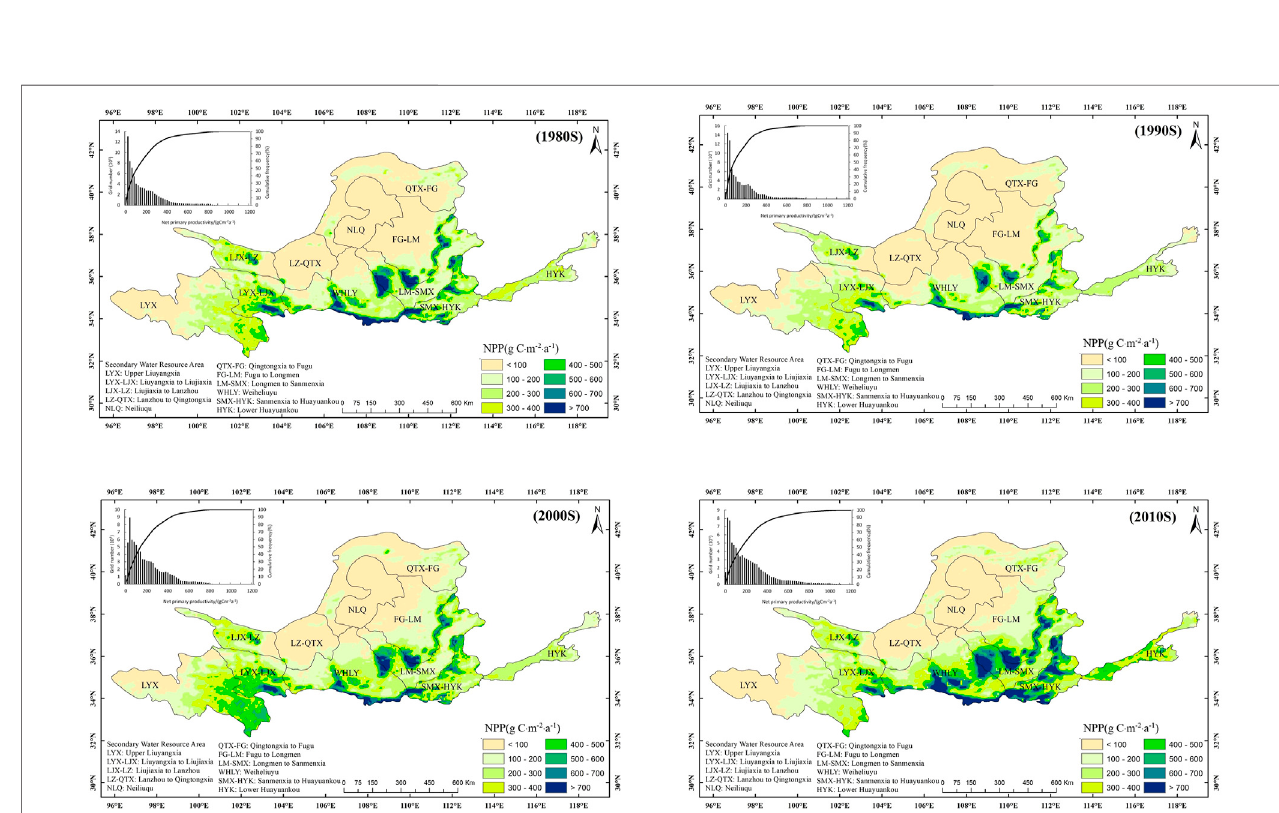
FIGURE 5 | Spatial distribution of 10-year average NPP from 1981 to 2020.